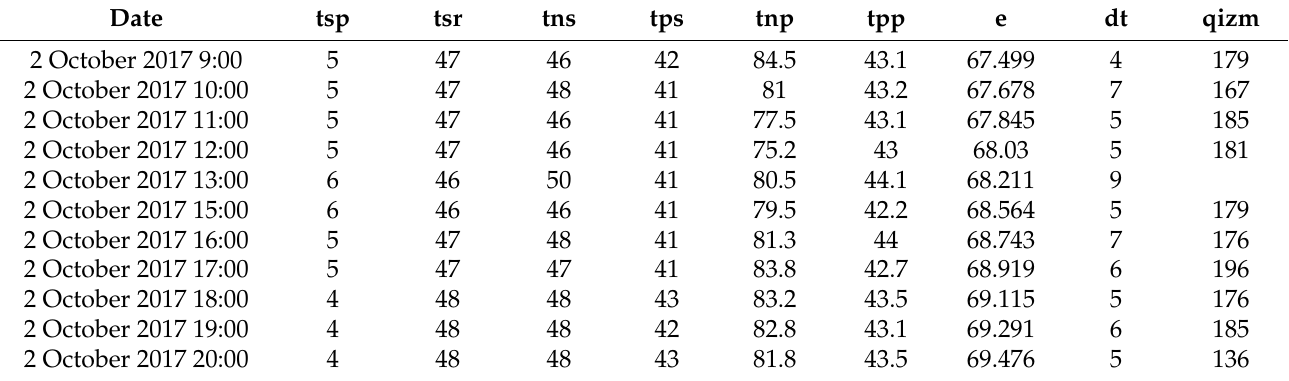
Table 3. Historical data for District Heating System substation operation for three seasons [50]. The dataset includes: Outside air temperature (C, tsp), water temperature in the secondary supply line (C, tns), water temperature in the secondary return line (C, tps), water temperature in the primary supply line (C, tns), water temperature in the primary return line (C, tps) and heat energy transmitted (Kw,